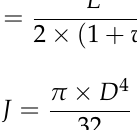
Table 1. Torsion bar material properties.